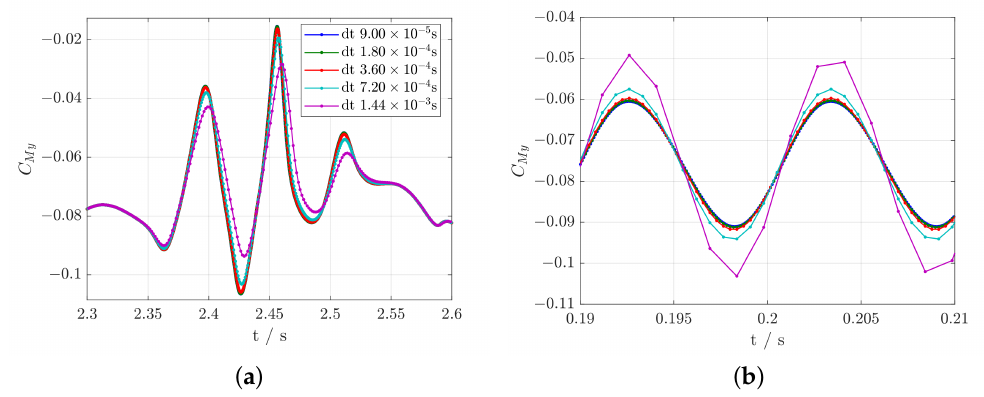
Figure A2. Comparison of different time step sizes at Mach 0.70. ( a ) L G = 125.5 m (k = 0.05), ( b ) L G = 2.5 m (k =